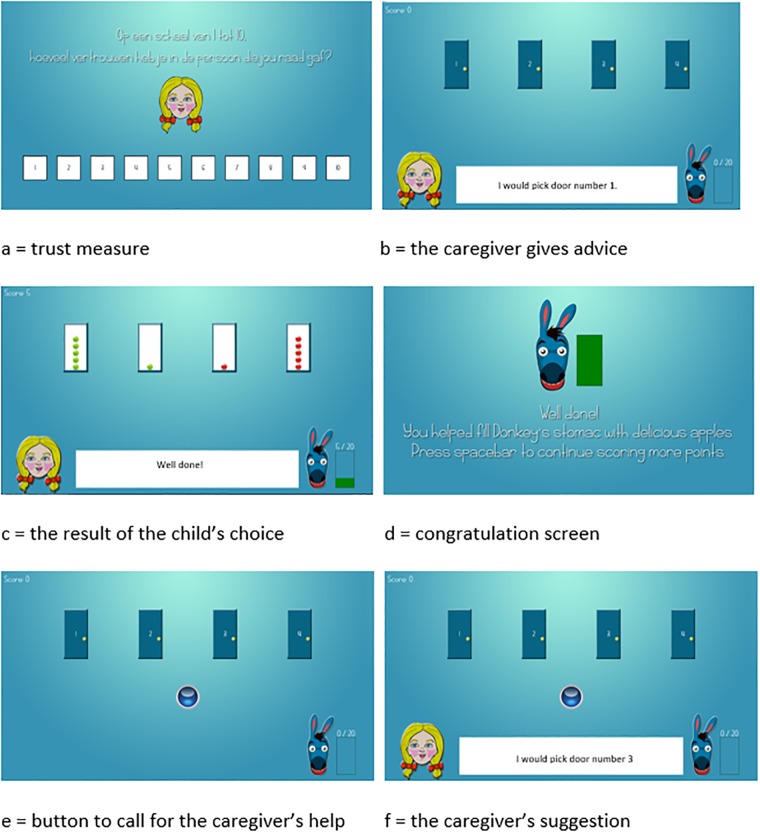
Trial presentation.